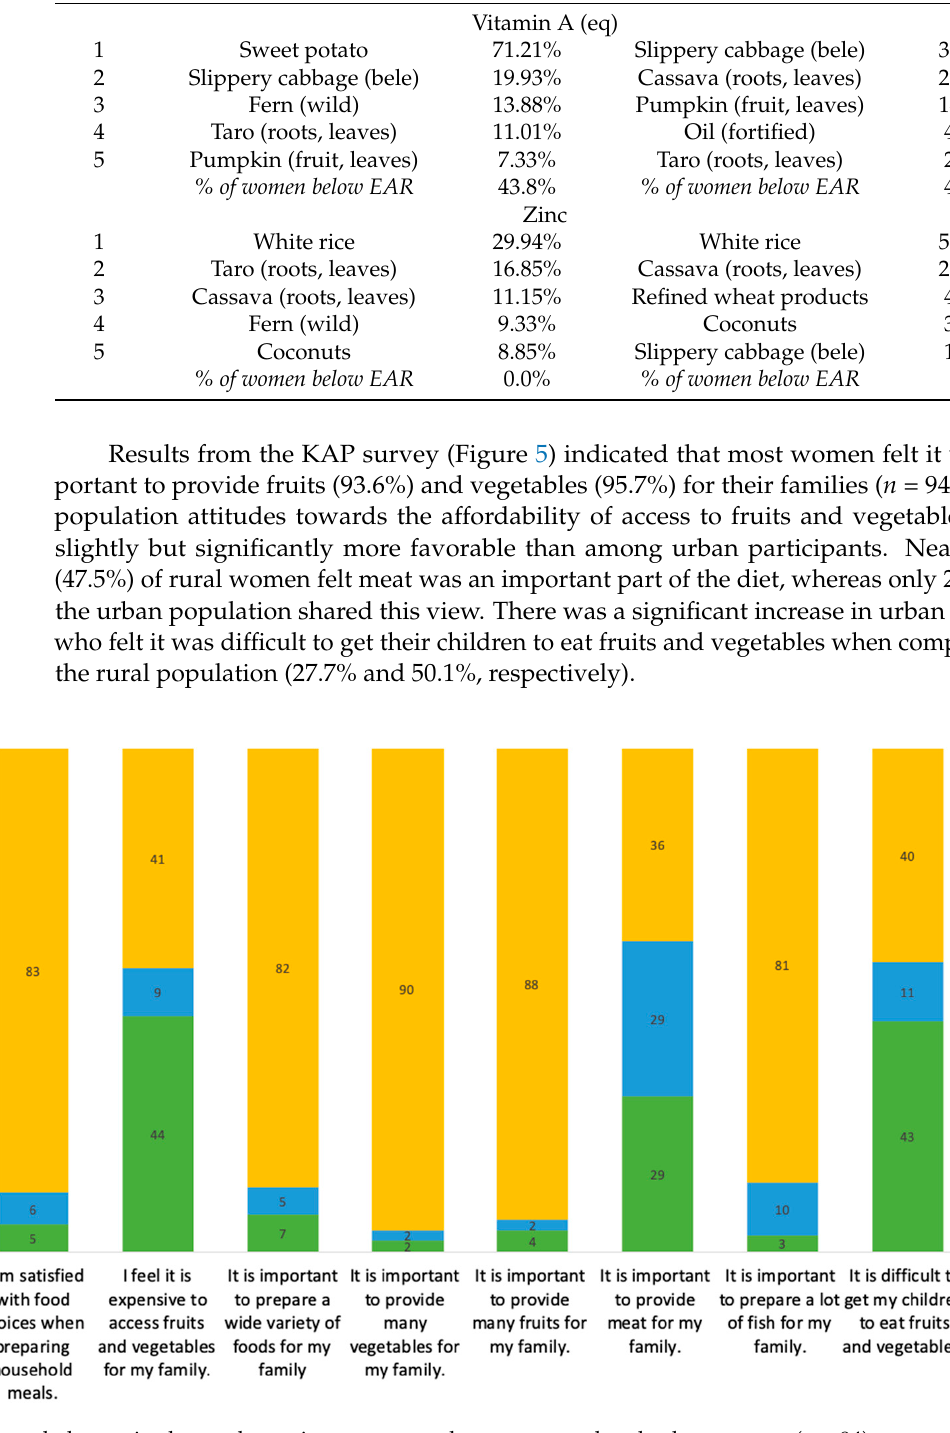
Figure 5. Knowledge, attitudes, and practice survey results among rural and urban women ( n = 94).